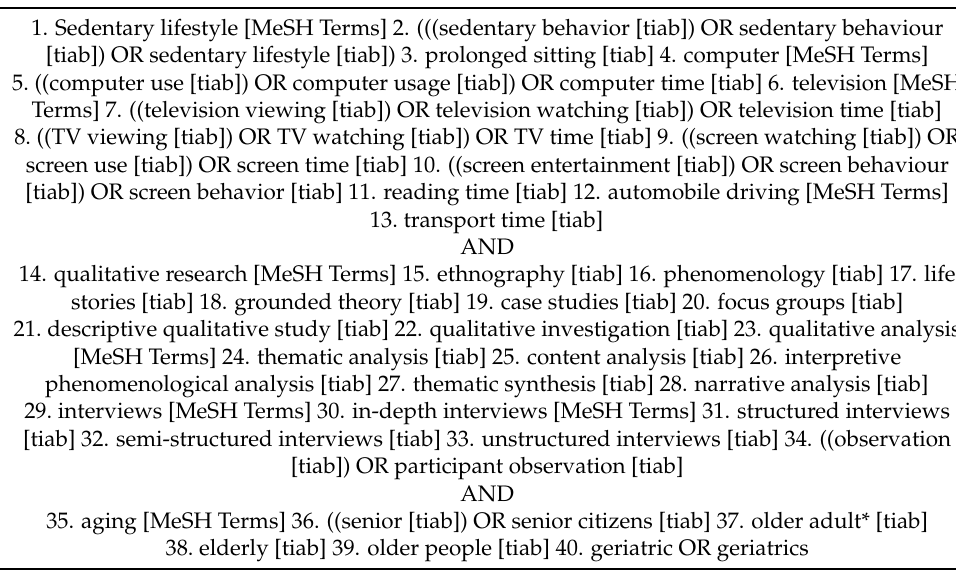
Table 1. PubMed search